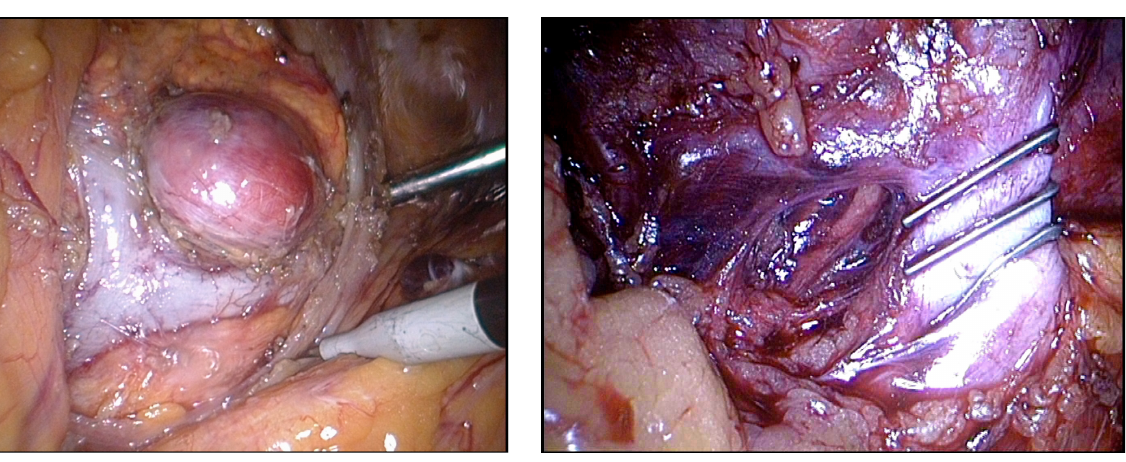
Figure 2: Left-sided incidental adrenal tumor – pheochromocytoma; intraoperative view